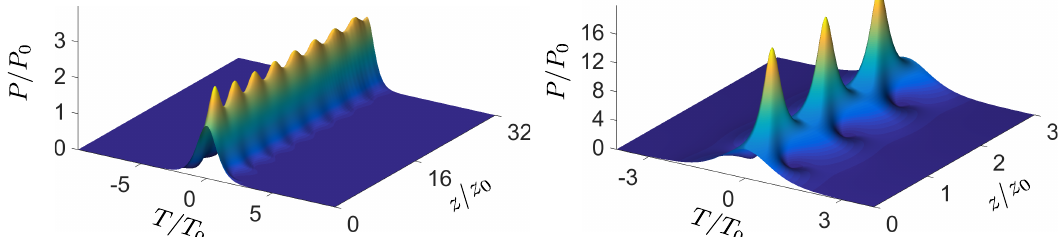
Figure 2. (Left) If a pulse with soliton order N = 1.2 is launched, a slowly decaying beat with radiation lets the soliton emerge gradually; (right) at N = 2, one generates a higher-order soliton, a structure with periodic shape